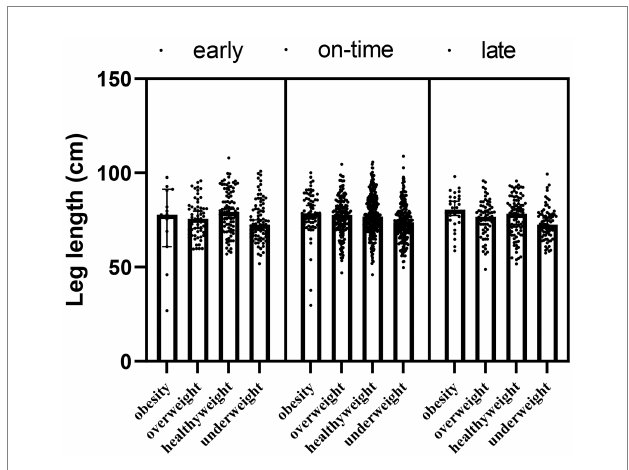
FIGURE 5 The leg length according to maturity and obesity groups of